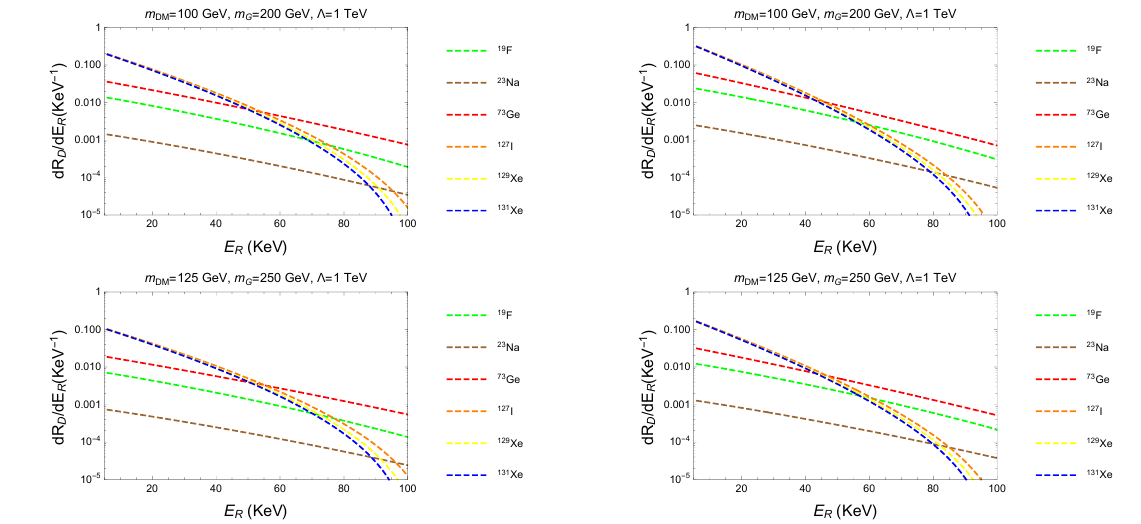
Figure 2 . Di(cid:11)erential event rates for fermionic dark matter (left) and scalar dark matter (right) for di(cid:11)erent experiments in table 2 for (cid:3) = 1 TeV and c (cid:31) = c = 1. Nucleus